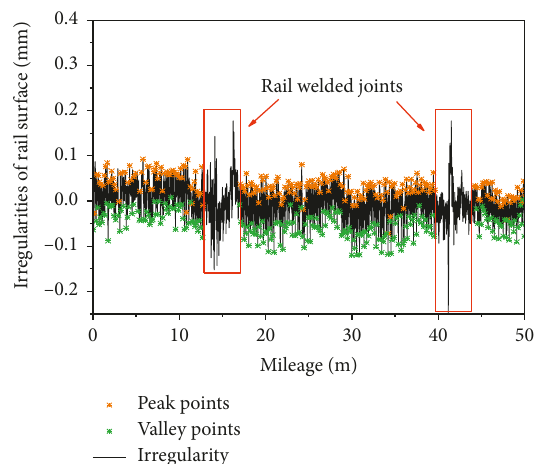
Figure 5: Irregularities on rails with short-wavelength corrugation.